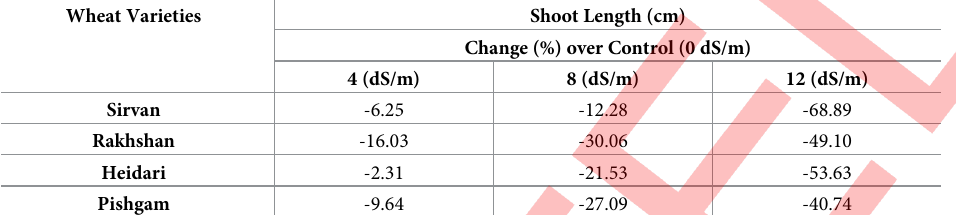
Table 4. Percentage change in shoot length of different wheat varieties as influenced by variable salinity levels. Wheat Varieties